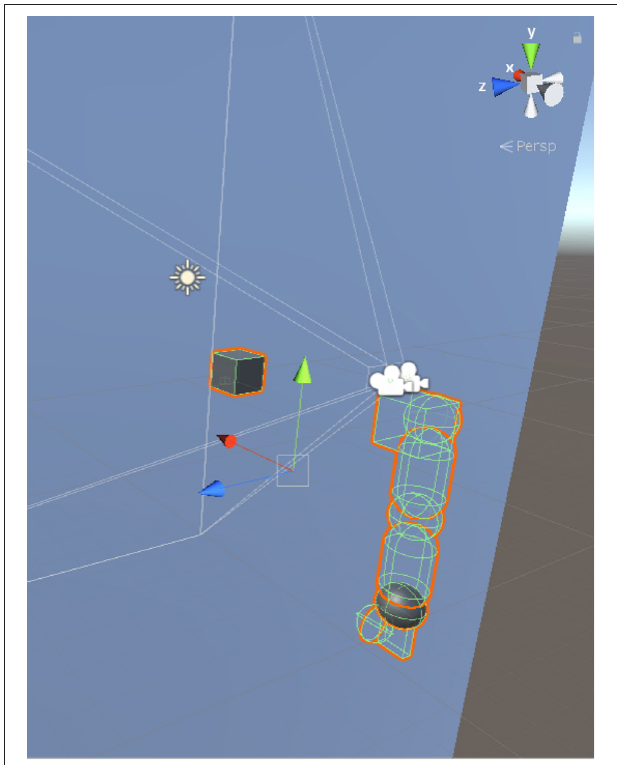
FIGURE 6 | Simulation environment in Unity3D. The axes indicated by the green and the red arrows are aligning with the axes marked by joint 2 and joint 0 in Figure 3 , respectively. The blue arrow is pointing inward the shoulder while joint 1 in Figure 3 is pointing outward the